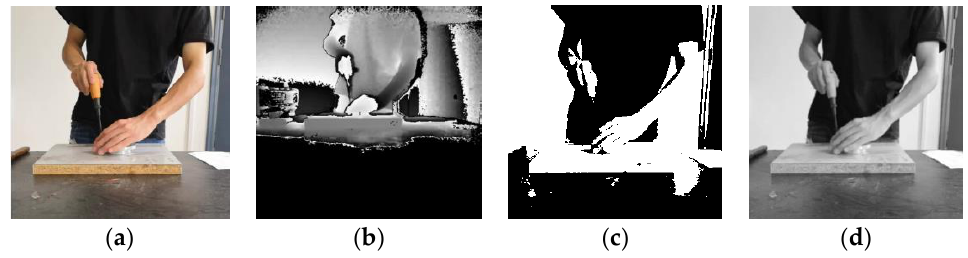
Figure 7. Comparison of the four image types of data set. ( a ) RGB image; ( b ) Depth image; ( c ) Binary image; ( d ) Gray image.